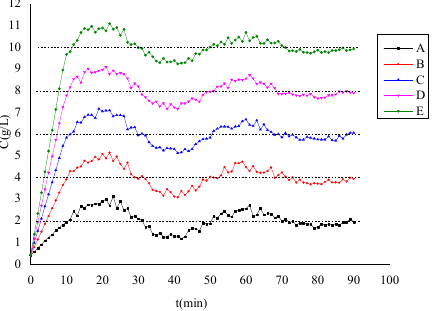
Figure 11. Variations of fertilizer concentration at different set values.